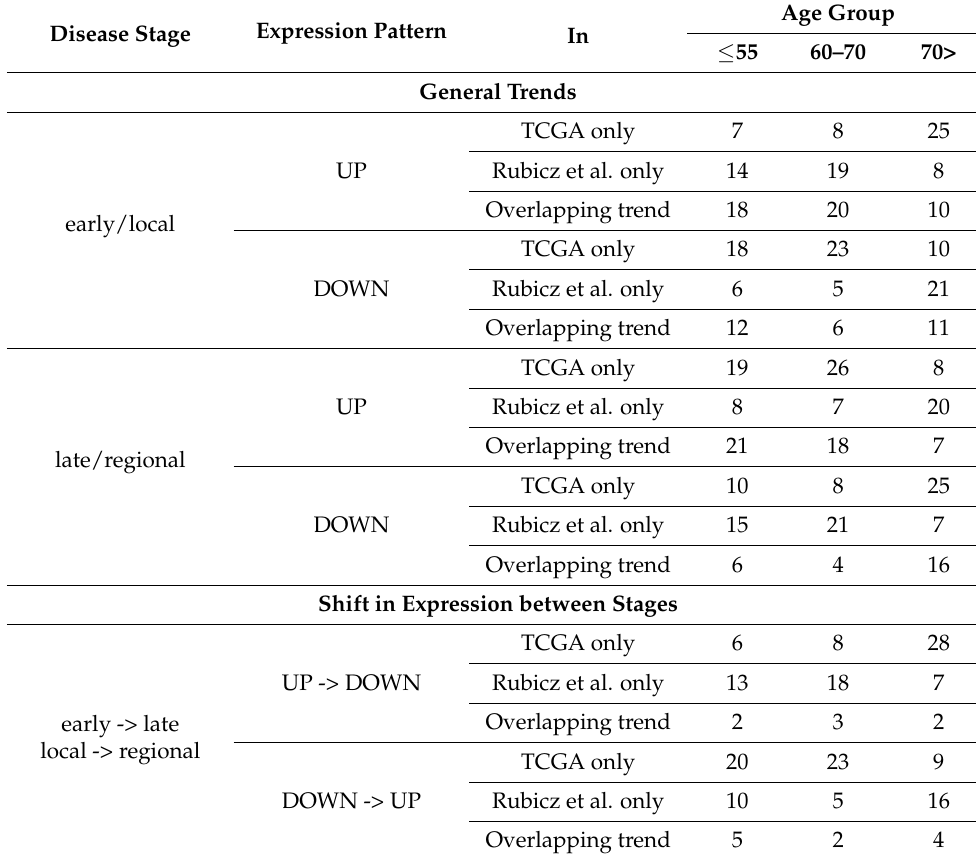
Table 2. Corroboration of the primary findings with validation cohort (detailed lists of genes are available in Supplementary Table